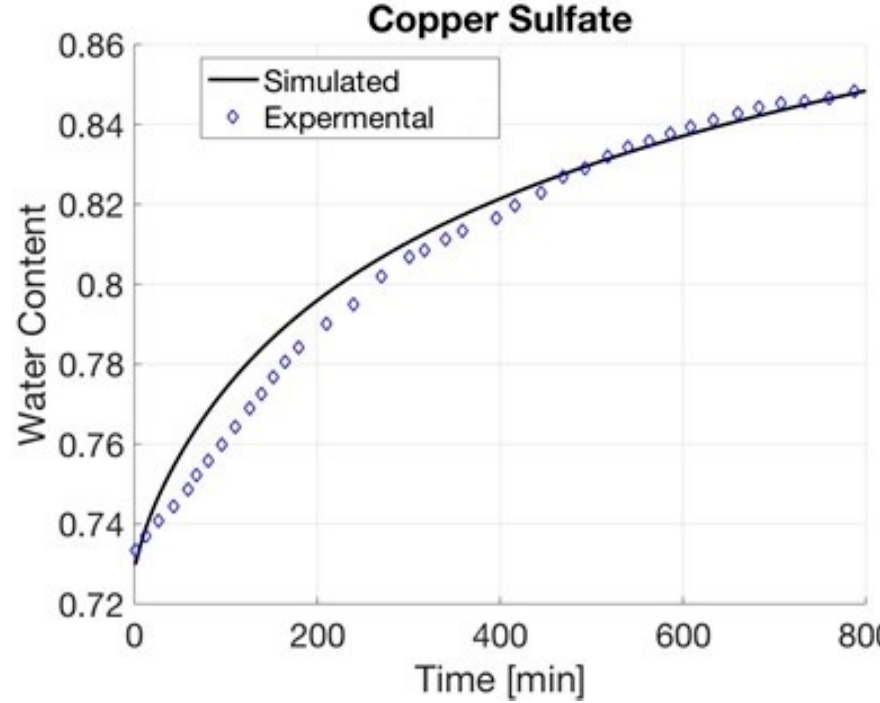
Figure 11. Comparison of HAW model of copper sulfate [27].